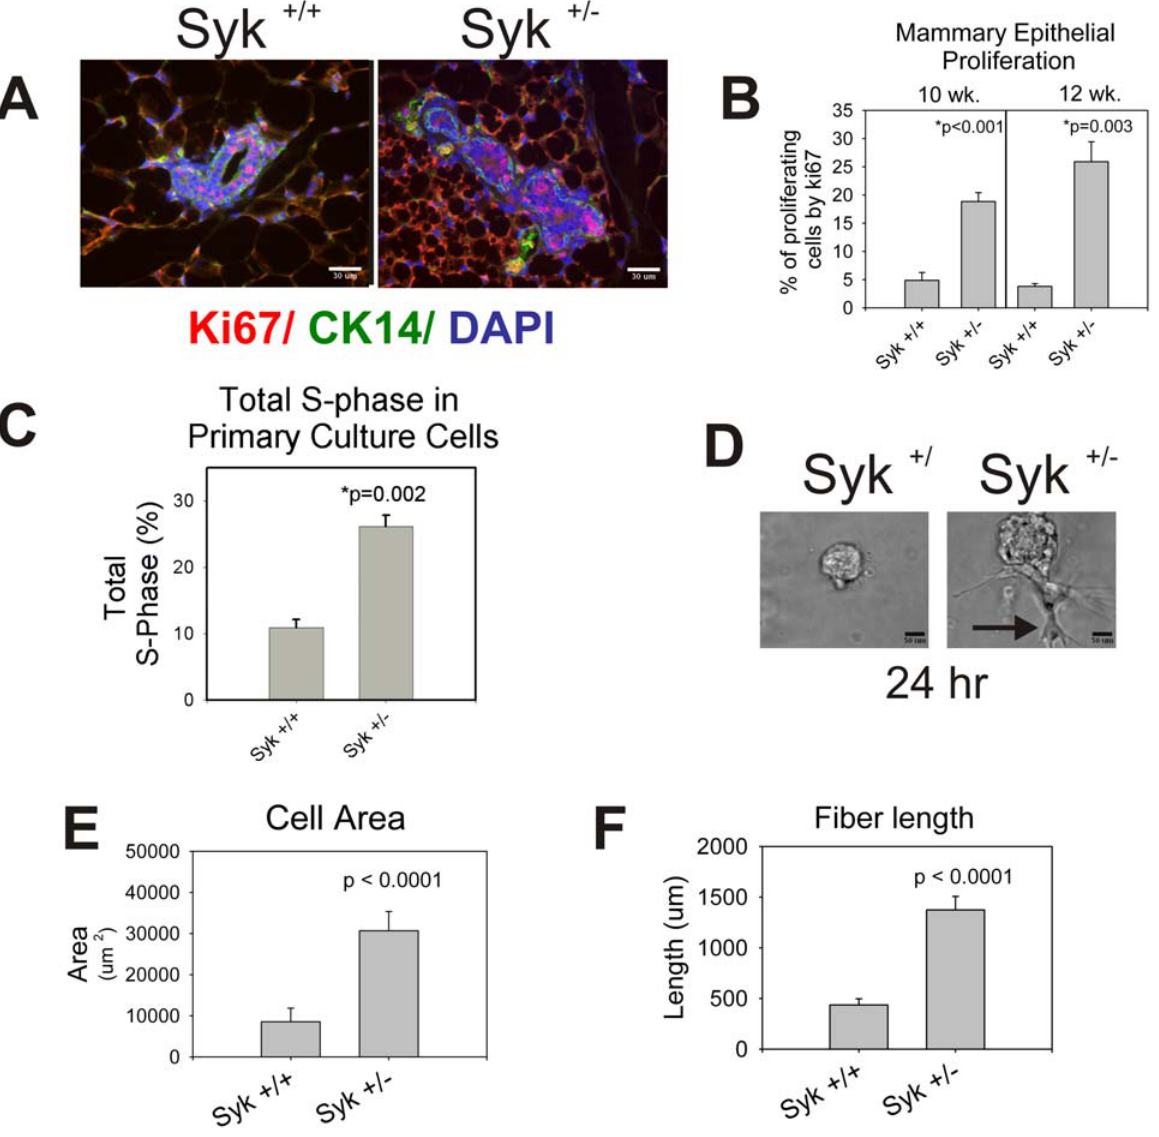
Figure 6. Heterozygous Syk knockout accelerates cell proliferation and invasiveness of mouse mammary epithelial cells. (A) Representative images illustrate sections triple stained with anti-Ki67 (red), anti-keratin14 (CK14m green), and DAPI (blue) from mammary glands of Syk + / + wild type and Syk + / 2 heterozygous mice from 12-week virgin females. Scale bars correspond to 30 m m. (B) Increased mammary epithelial cell proliferation was quantified from images illustrated in (A) in three animals for each point. (C) Primary cell cultures also exhibit increased cell proliferation. Total % of cells in S-phase was quantified in primary cells from Syk + / + wild type and Syk + / 2 heterozygous mice from 12-week virgin females. (D) Freshly isolated primary mammary epithelial cells were embedded Matrigel. Organoids were imaged at 24 hrs and show greatly enhanced size in Syk heterozygous knockdown compared with wild type glands. A typical invasive leading edge is indicated (arrow). Scale bars correspond to 50 m m. Increased cellular area (E) and fiber length (F) of organoids was assessed using Metamorph Image software. In all cases (B–F) , data is represented by means + / 2 SEM. P values are significant by the student’s t-test.